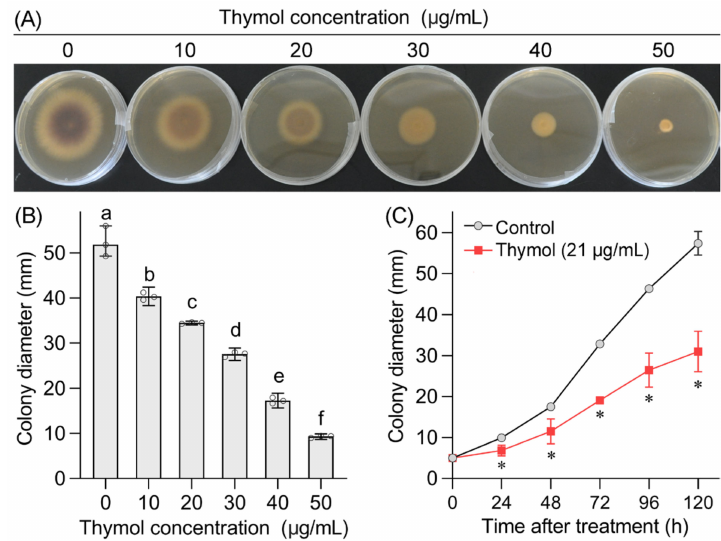
Figure 1. Thymol inhibited radial growth of FON . ( A ) Phenotype of mycelial growth on PDA plate under thymol treatment for 120 h. ( B ) Colony diameter of FON under thymol treatment for 120 h. ( C ) Time-course measurement of FON colony diameter under thymol (21 µ g/mL). Bars indicated SD of three replicates. Different lowercase letters in ( B ) indicated significant difference among different treatments (LSD, n = 3, p < 0.05). Asterisk in ( C ) indicated significant difference between control and thymol treatment at each time point (ANOVA, n = 3, p < 0.05).